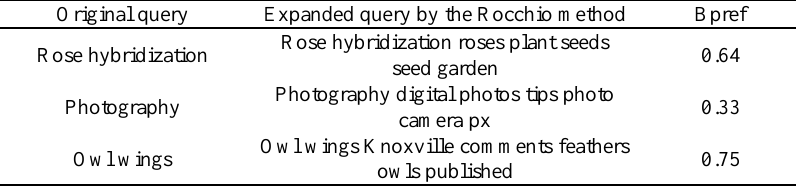
Table 2. Example of Rocchio method's results